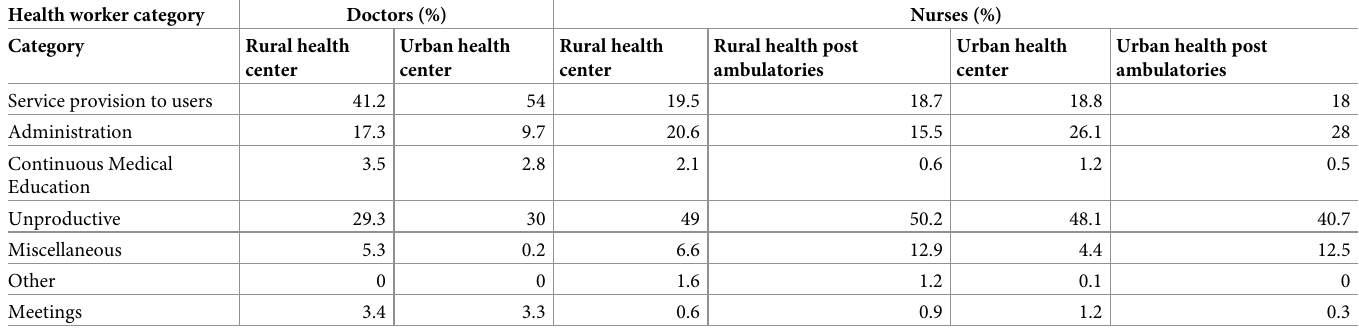
Table 3. Percentage of overall time allocation (including outreach time) by HWs category at rural and urban settings.